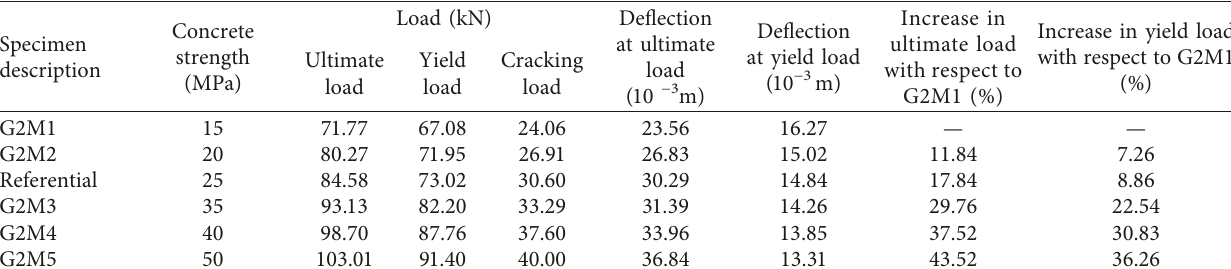
Table 10: Load-deflection response of specimens with different concrete